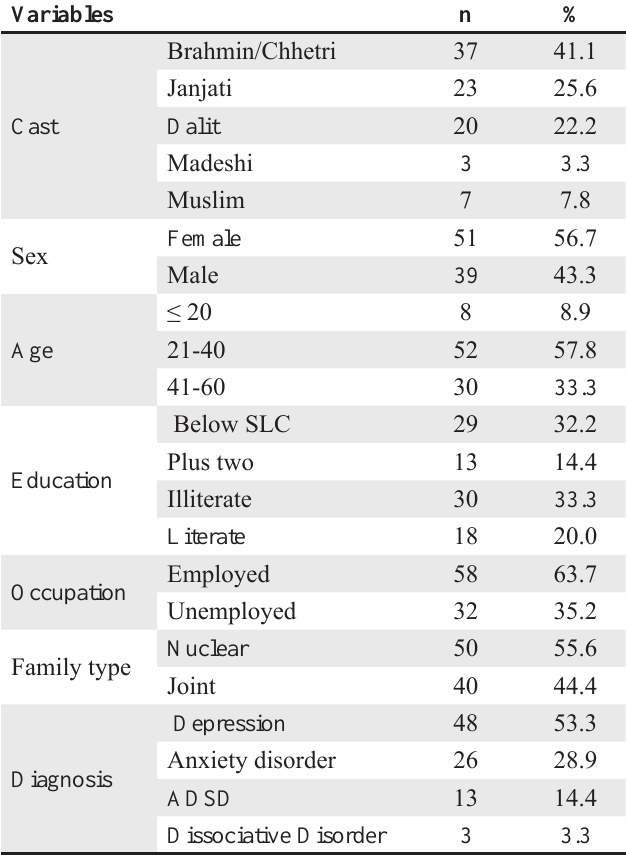
Table 1 : Demographic characteristics of the participants (N=90)